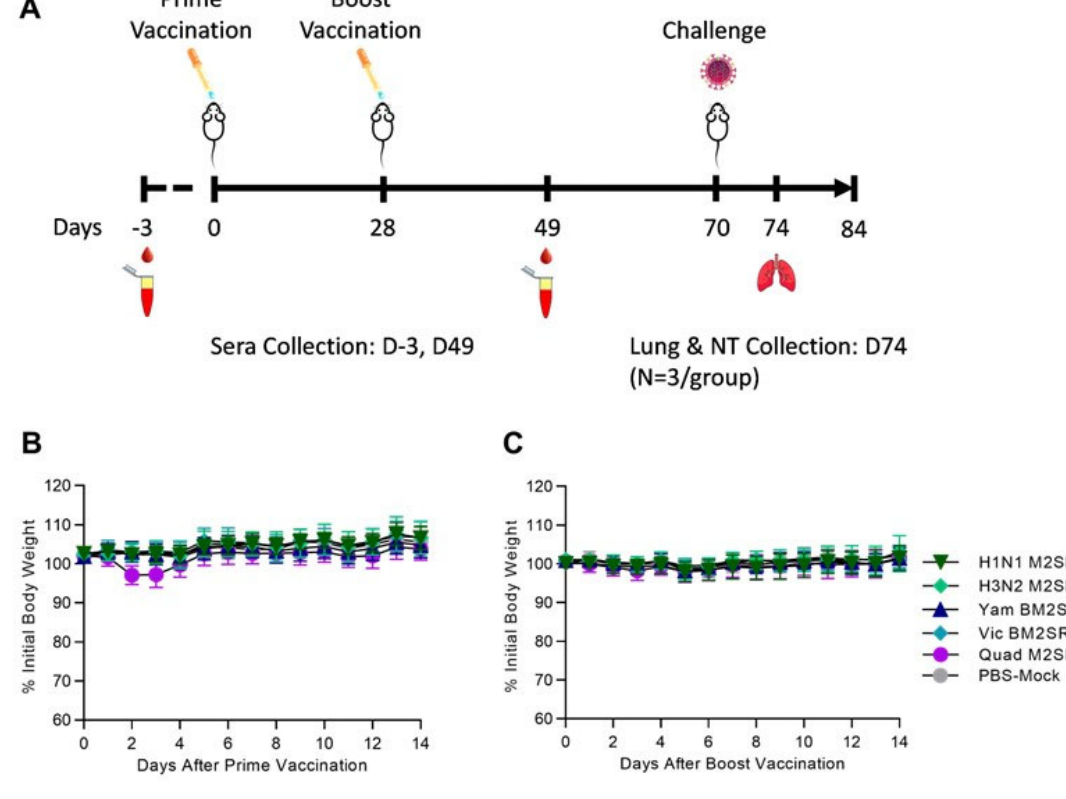
Figure 1. Vaccination scheme, sampling regimen, and body weight changes in mice follow- ing M2SR vaccination. ( A ) Groups of BALB/c were intranasally vaccinated with H1N1 M2SR (A/California/07/2009), H3N2 M2SR (A/Brisbane/10/2007), Yam BM2SR (B/Wisconsin/01/2010), Vic BM2SR (B/Brisbane/60/2008), or each of the four monovalent strains formulated together (Quad M2SR) on Day 0 and again on Day 28. Serum samples were collected pre-study and on day 49. Mice were challenged with a 40 MLD 50 dose of A/Aichi/2/68 (H3N2) or a 20 MLD 50 dose of B/Malaysia/2506/2004 (Victoria lineage) on Day 70. Lung and nasal turbinates were collected from 3 mice/group on Day 74. Body weight was monitored for 14 days following prime inoculation ( B ), and again 28 days later following boost inoculation ( C ).